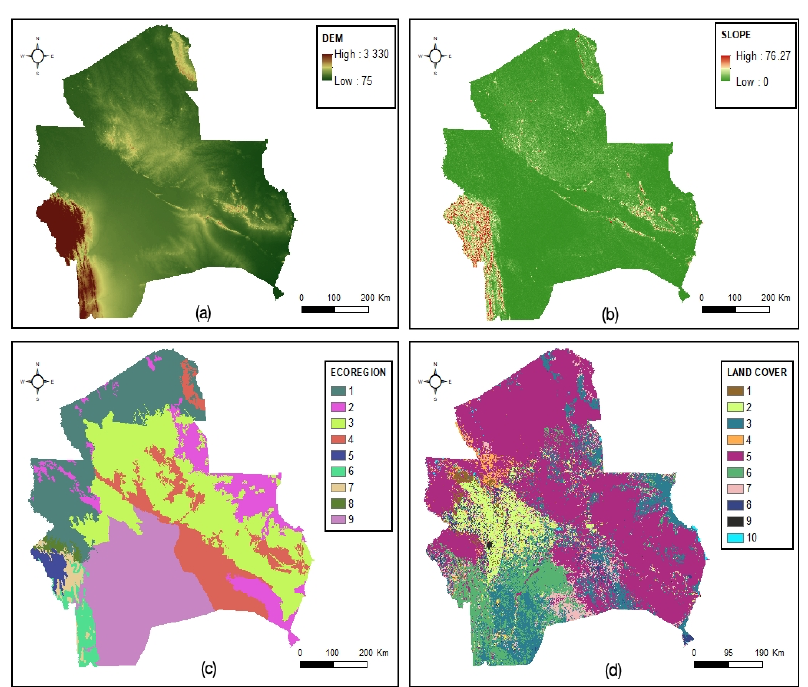
Figure 6. Predisposing factors: ( a ) DEM (Altitude, in meters), ( b ) Slope (in degrees), ( c ) Ecoregions, and ( d ) Land cover classes (see Table 2 for class